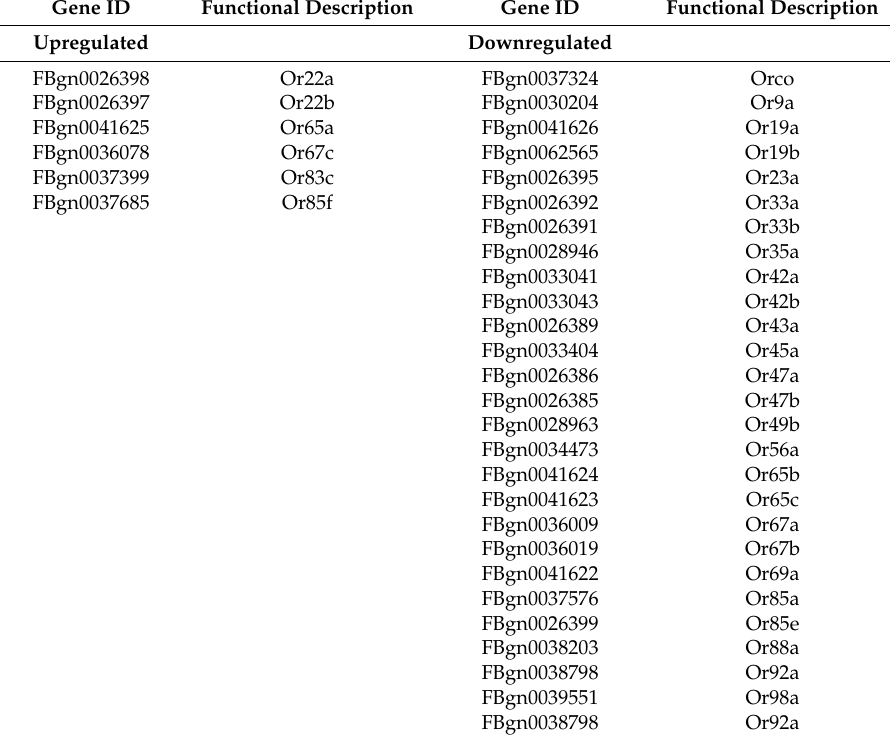
Table 2. Olfactory receptor (Or) genes: Down- and up-regulated after 14 days HFD